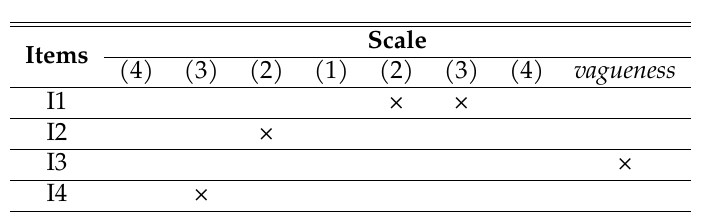
Table 1: An employee’s answers to ORI – 4